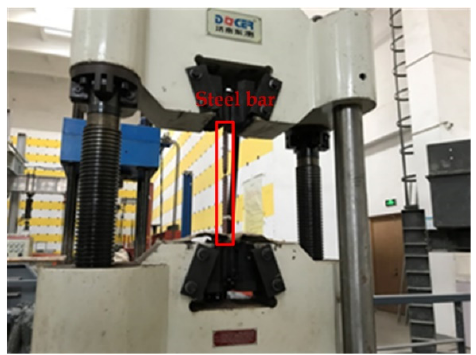
Figure 10. Tensile test experiment of corroded longitudinal steel bars.